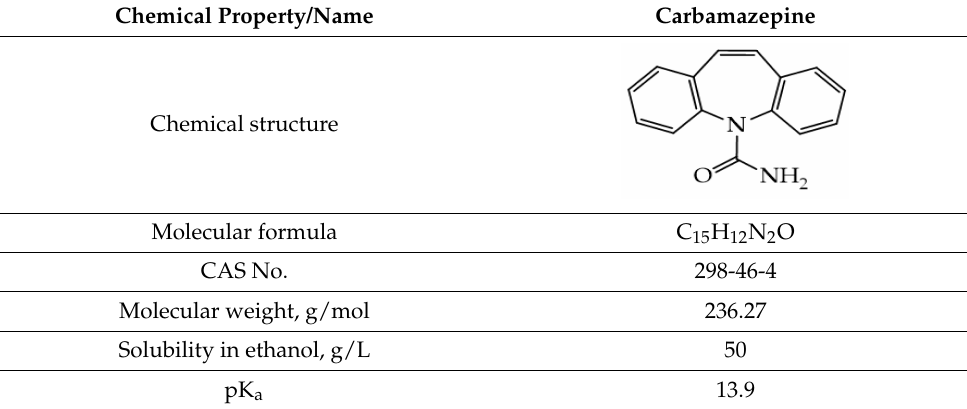
Table 2. Physico-chemical properties of carbamazepine (CBZ).